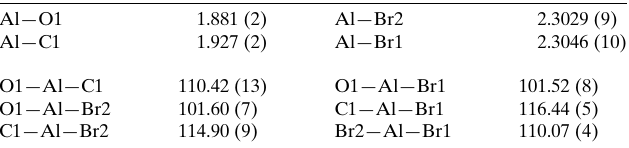
(cid:5) z ). Atomic displacement 2